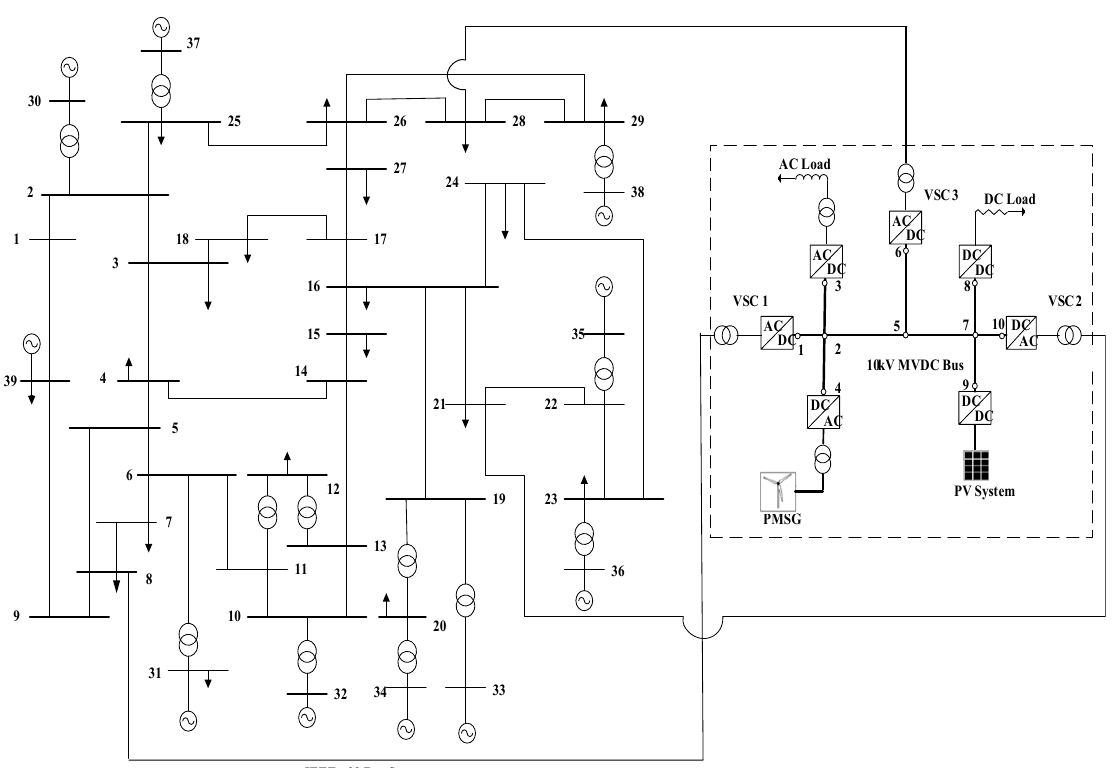
Figure 9. Multiterminal MVDC distribution network connected to the IEEE–39 Bus System.